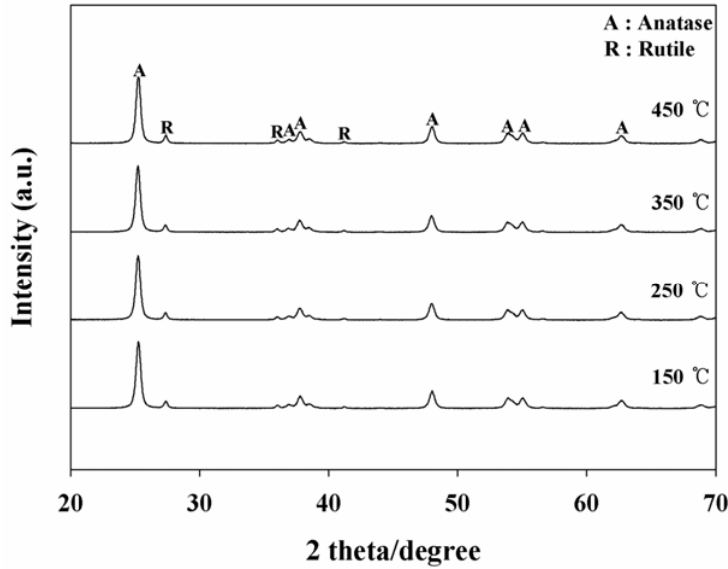
Figure 2. X-ray diffraction spectra of photocatalysts baked at four different temperatures (150, 250, 350, or 450 °C).